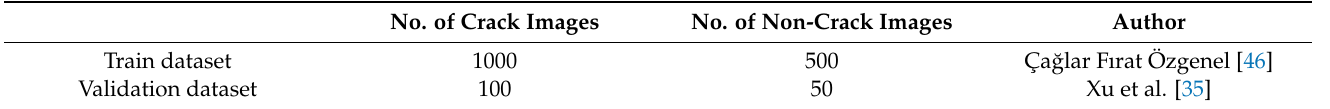
Table 3. Datasets for